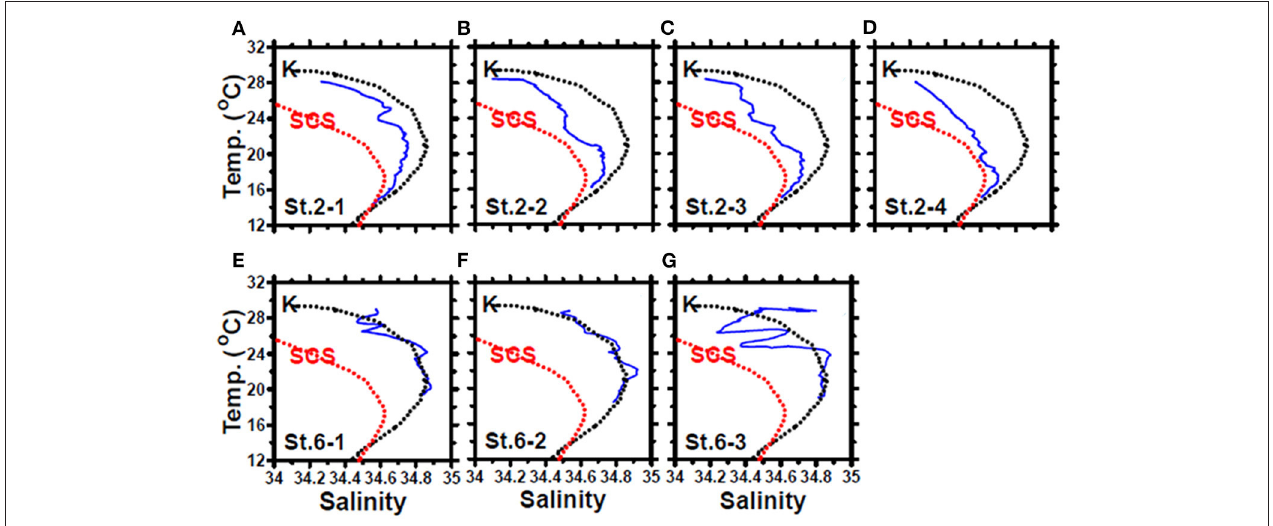
FIGURE 3 | The temperature–salinity diagrams of the casts deployed at stations 2 (A–D) and 6 (E–G) of the May cruise. The black and red dashed lines represent the typical Kuroshio Current (KC) and South China Sea (SCS) waters, respectively. The data were collected from the Ocean Data Bank, Taiwan (http://www.odb.ntu.edu. tw/). The first and second numbers of the abbreviation St. x–x in each panel indicate the sampling station and the hydrocast deployed at that station,